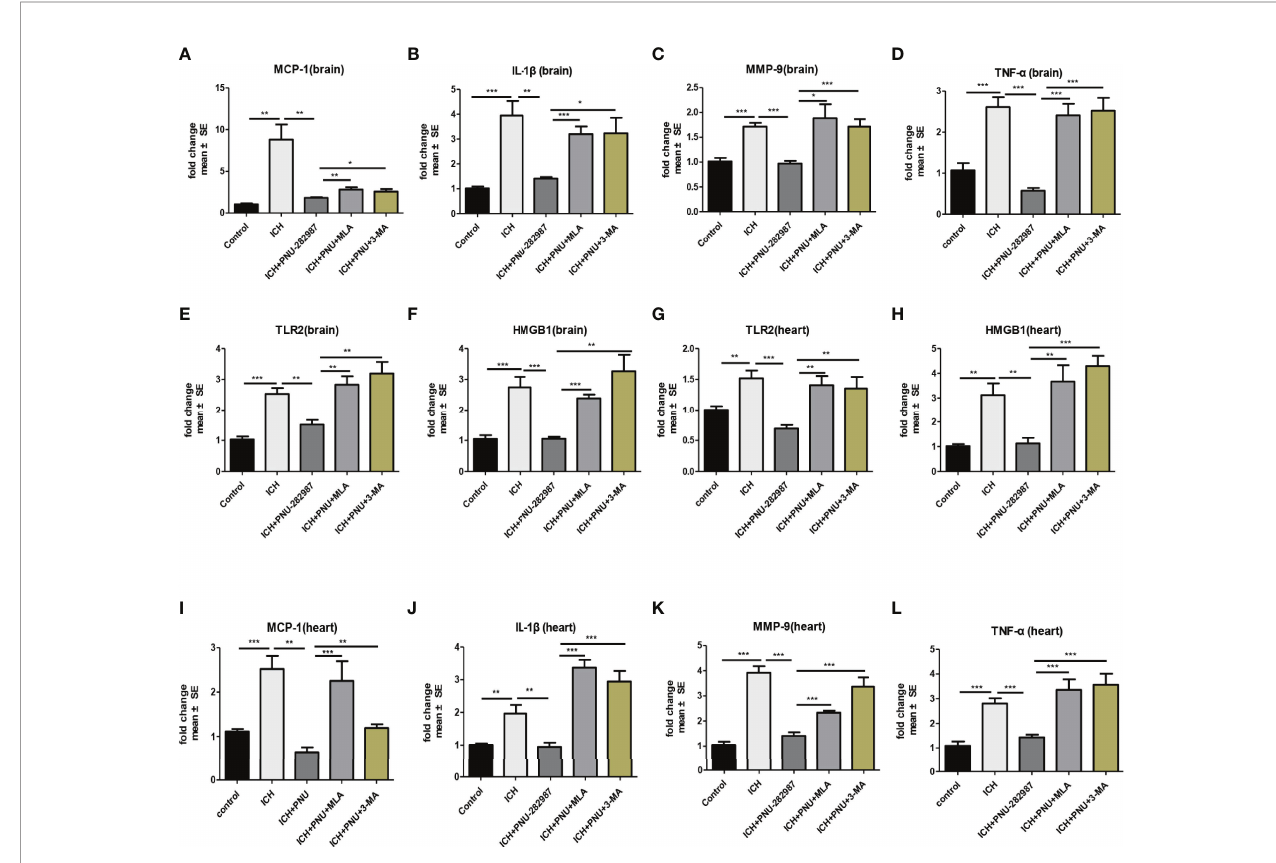
FIGURE 10 | Activating a 7nAChR decreased ICH-caused oxidative stress and in fl ammatory responses in the brain and heart. (A – F) PCR results indicated that PNU-282987 remarkably decreased ICH-induced in fl ammatory factor expression as MCP-1, IL- b , MMP-9, TNF- a , TLR2 and HMGB1 compared to control mice in brain at 7 days after ICH. (G – L) PCR results indicated that PNU-282987 signi fi cantly reduced gene expression of ICH-induced in fl ammatory factor as TLR2, HMGB1, MCP-1, IL- b , MMP-9 and TNF- a compared to control mice in heart at 7 days after ICH. n = 6 per group for echocardiography. Data are presented as mean ± SE; *p < 0.05; **P < 0.01; ***P <